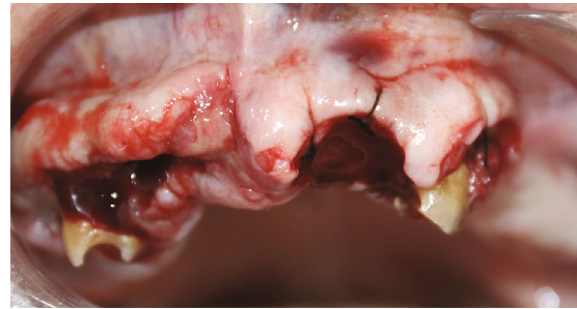
Figure 8: Gingiva removed from the upper left quadrant and extracted teeth (#11 and #21).